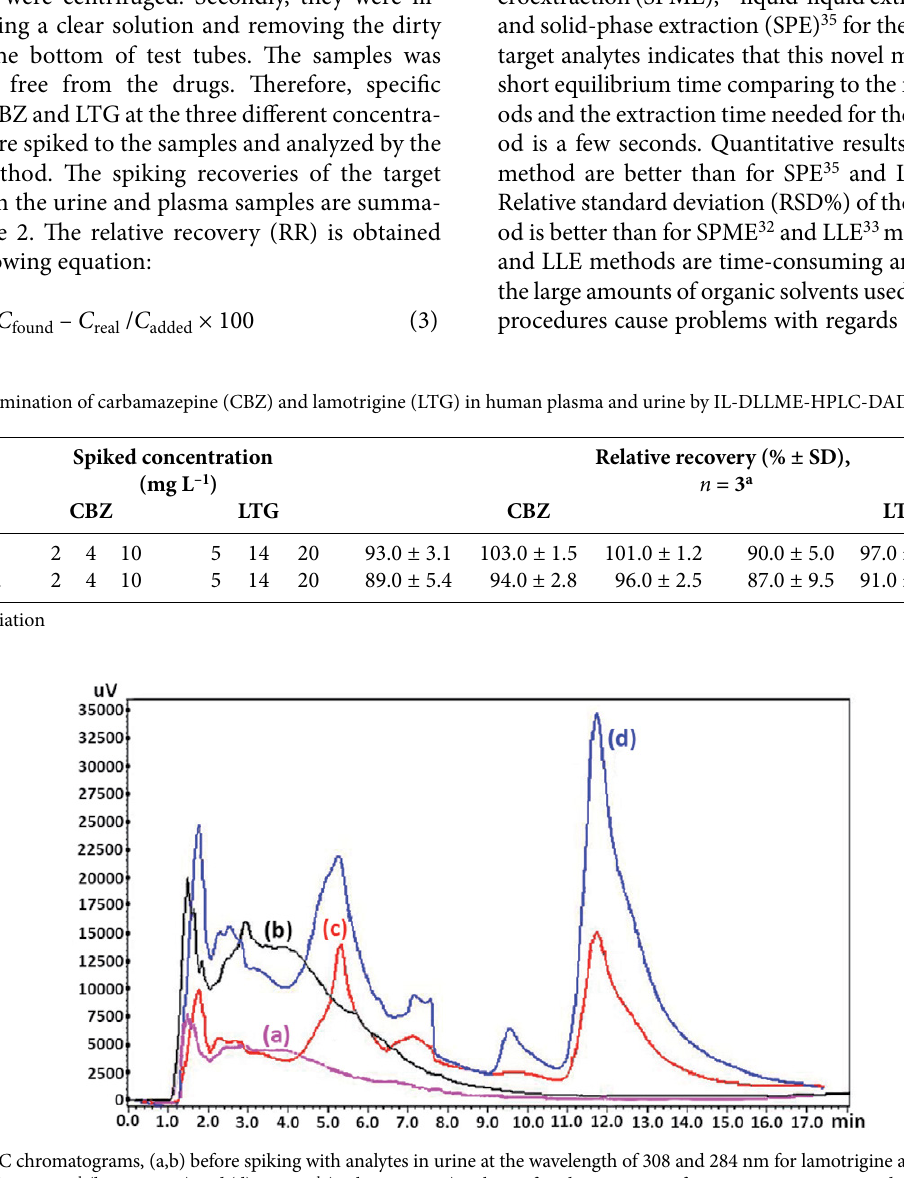
Figure 8. HPLC chromatograms, (a,b) before spiking with analytes in urine at the wavelength of 308 and 284 nm for lamotrigine and carbamazepine, respectively, (c) 14 mg L –1 (lamotrigine) and (d) 4 mg L –1 (carbamazepine) spiking of analytes in urine after extraction via proposed method at optimum conditions . (The retention time of LTG was 5.1 min and the retention time of CBZ was 12.1 min at the measurement in the maximum